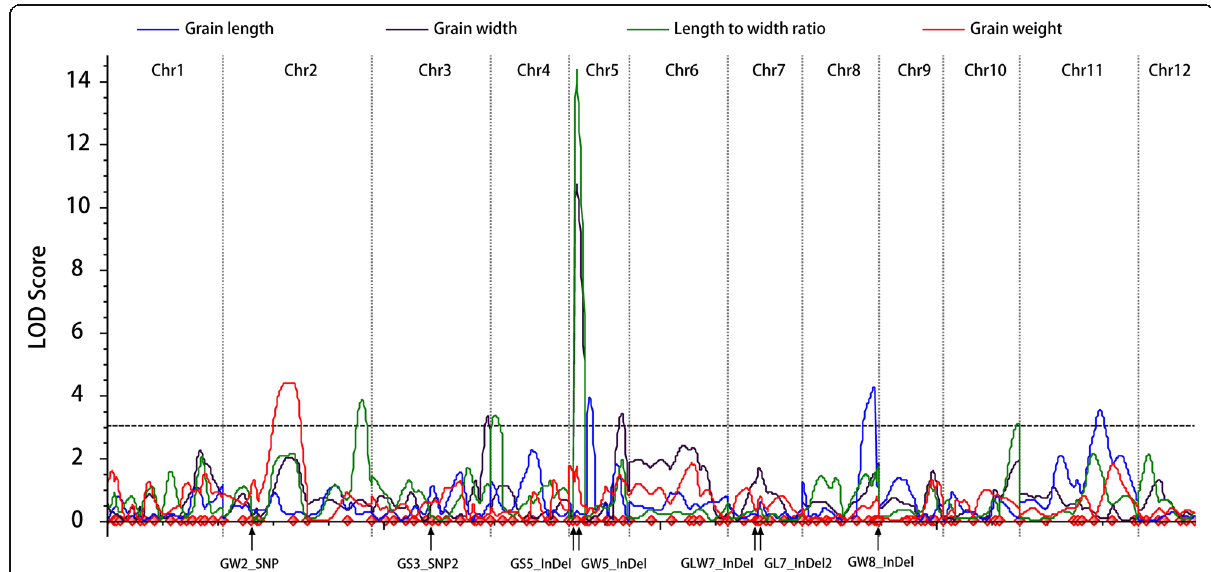
Fig. 7 Contribution of polymorphic markers in the QTL analysis. QTL analysis was performed using 123 markers across all 12 chromosomes, and LOD score of the four grain size traits are shown by different colors. The horizontal dashed line indicates the threshold for QTL detection, and peaks over the threshold represent the existence of QTLs. The red diamonds correspond to the position of all the markers used for QTL analysis, and arrows denote positions of seven polymorphic functional markers for grain